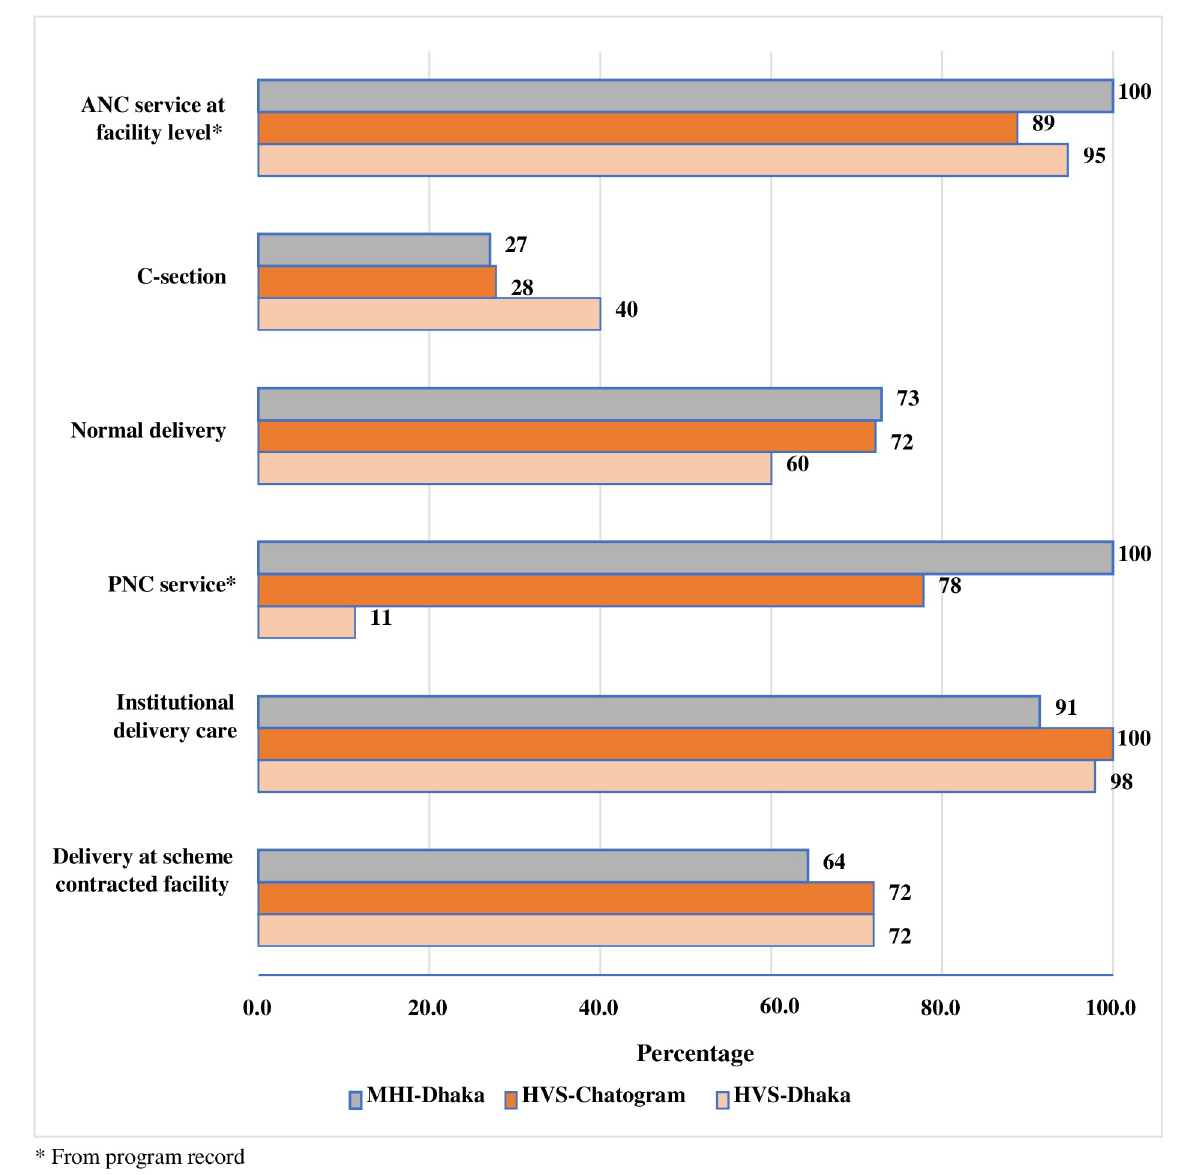
Fig 1. Percentage coverage of MNCH